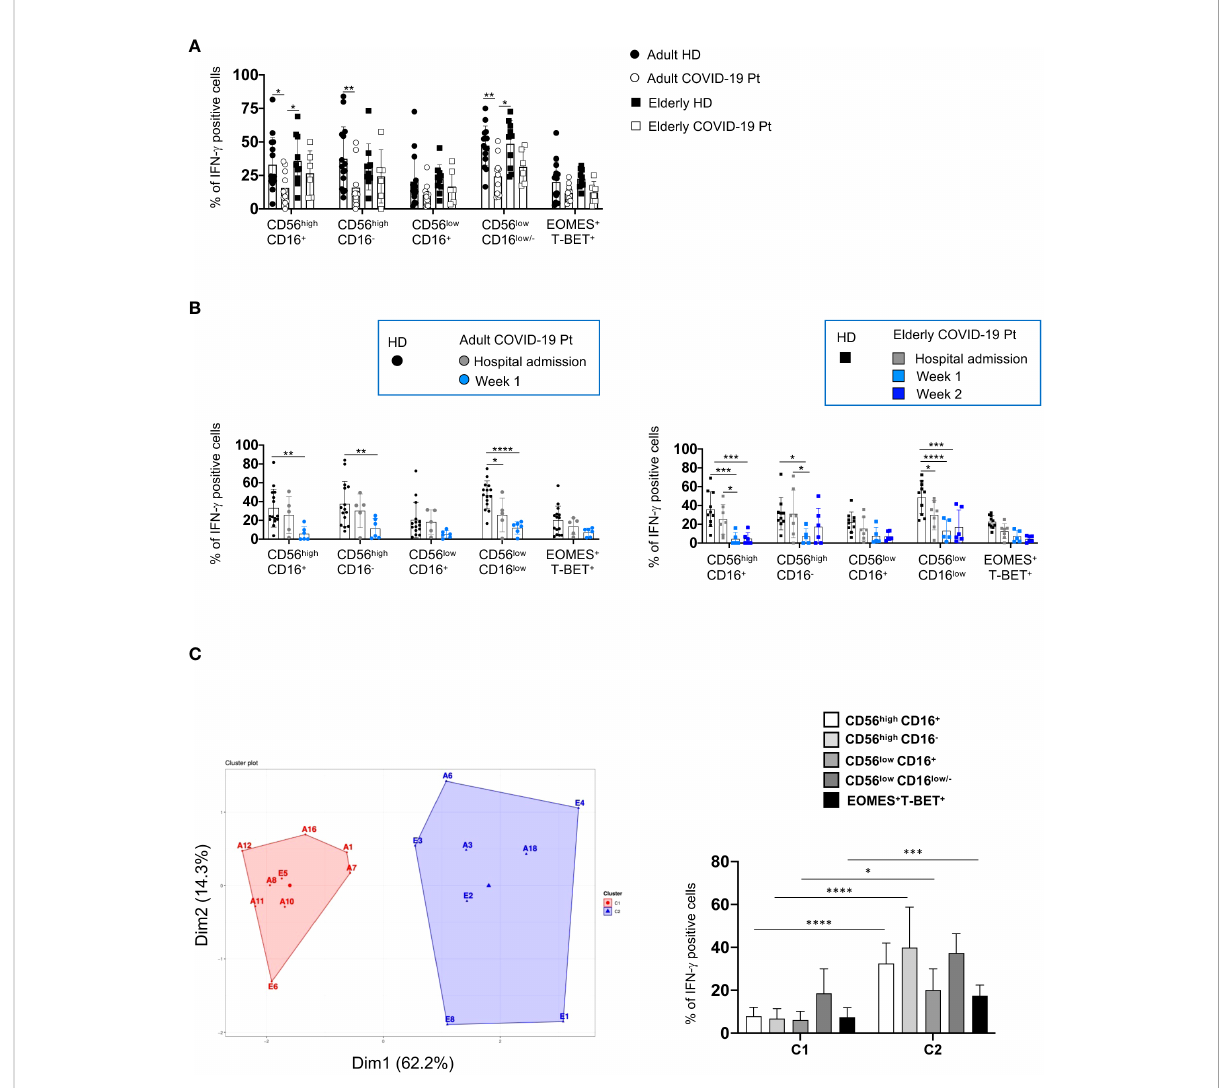
FIGURE 9 Differential ability of producing IFN- g by adult and elderly COVID-19 NK cell subsets. The frequency of IFN- g positive cells, upon IL-12 plus IL- 18 stimulation, is shown for each NK cell subset from adult and elderly COVID-19 patients compared with healthy controls early after hospital admission (A) and at different times after hospitalization in adult and elderly patients (B) . Histograms represent the mean ± SD. K-means clustering of our patient cohort identi fi ed two clusters based on IFN- g production by NK cell subsets and the hospitalization time (Supplementary Table S3) (left panel) (C) . These two clusters differentially present the indicated population for IFN- g production (right panel). *p< 0.05, **p< 0.01, *** p< 0.001, **** p< 0.0001 . Two-way analysis of variance (ANOVA) and Sidak ’ s